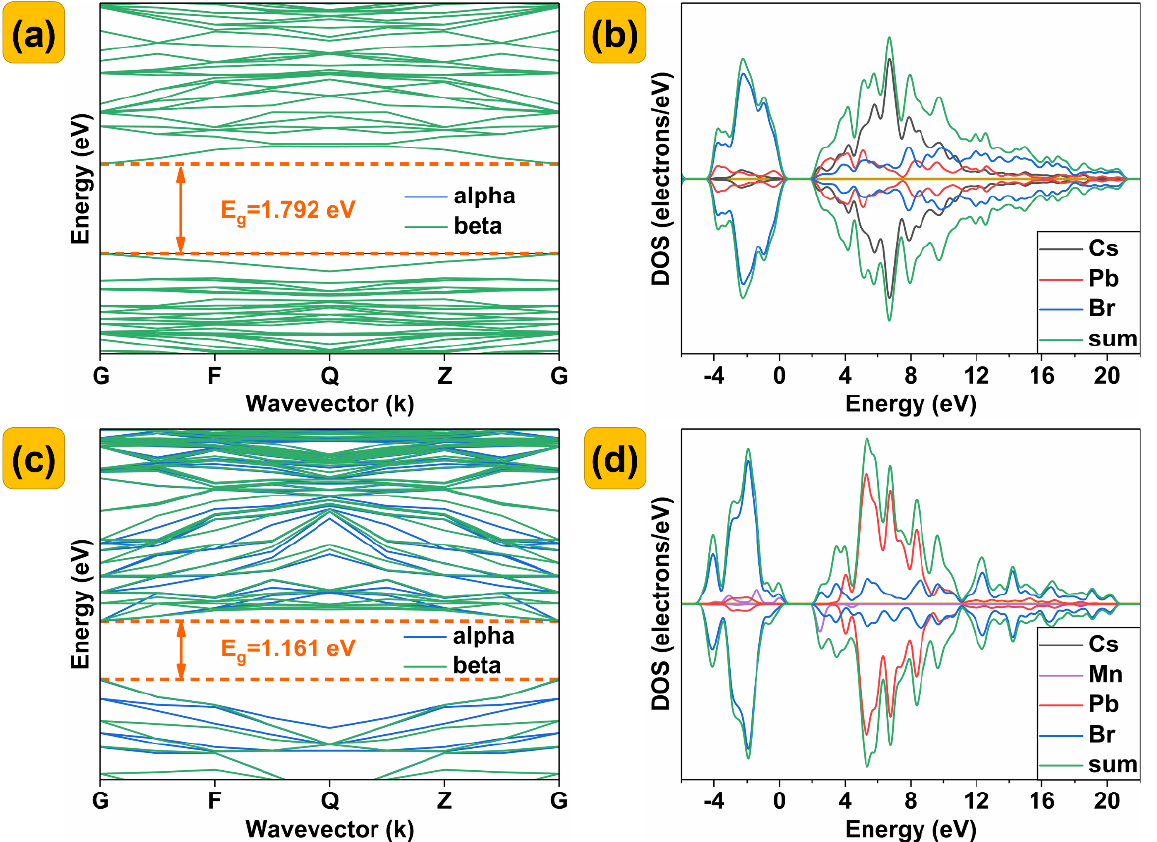
Figure 5. ( a , c ) Band structure, ( b , d ) partial density of states of CsPbBr 3 and Cs(Pb 0.875 Mn 0.125 )Br 3 , suggesting that the perovskite CsPbBr 3 belongs to a direct band−gap semiconductor.